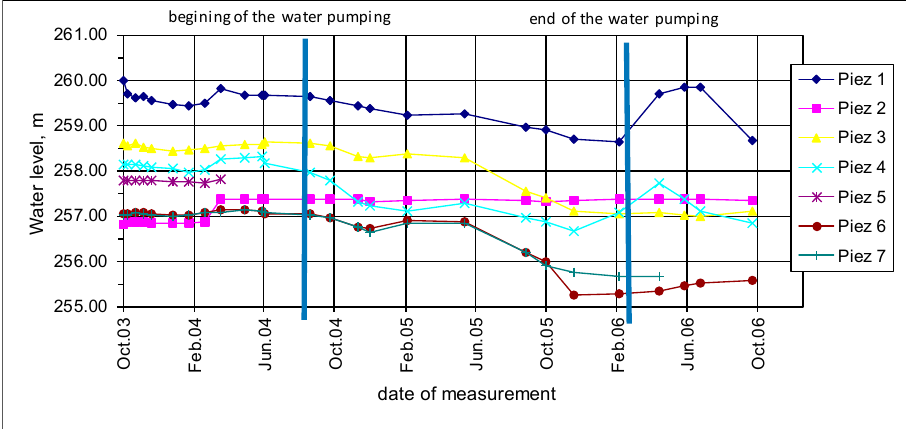
Figure 11. Change in water level measured in individual piezometers (construction of the tunnel under the roundabout in Katowice).